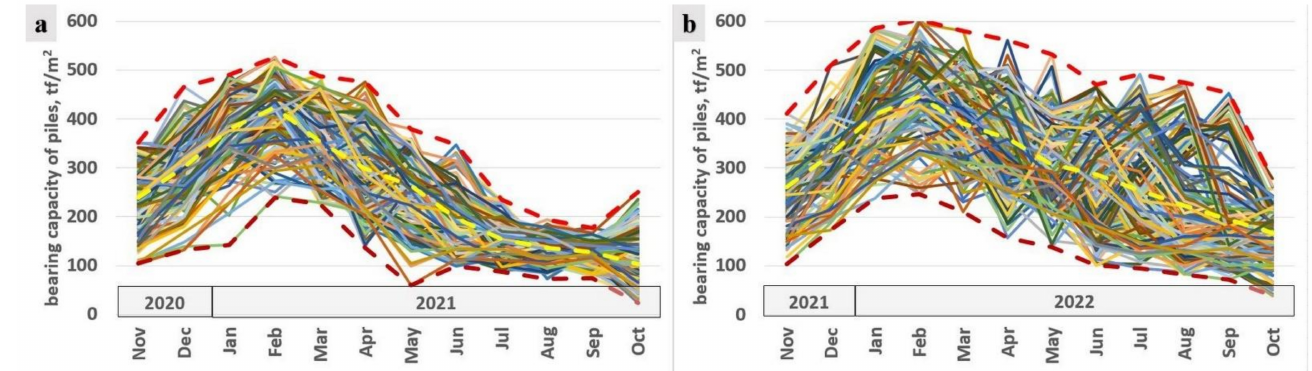
Figure 21. Dynamics of change in the predicted change in the bearing capacity of piles in 2021 ( a ) in comparison with the obtained change in the bearing capacity of piles in 2022 ( b ) in tf/m 2